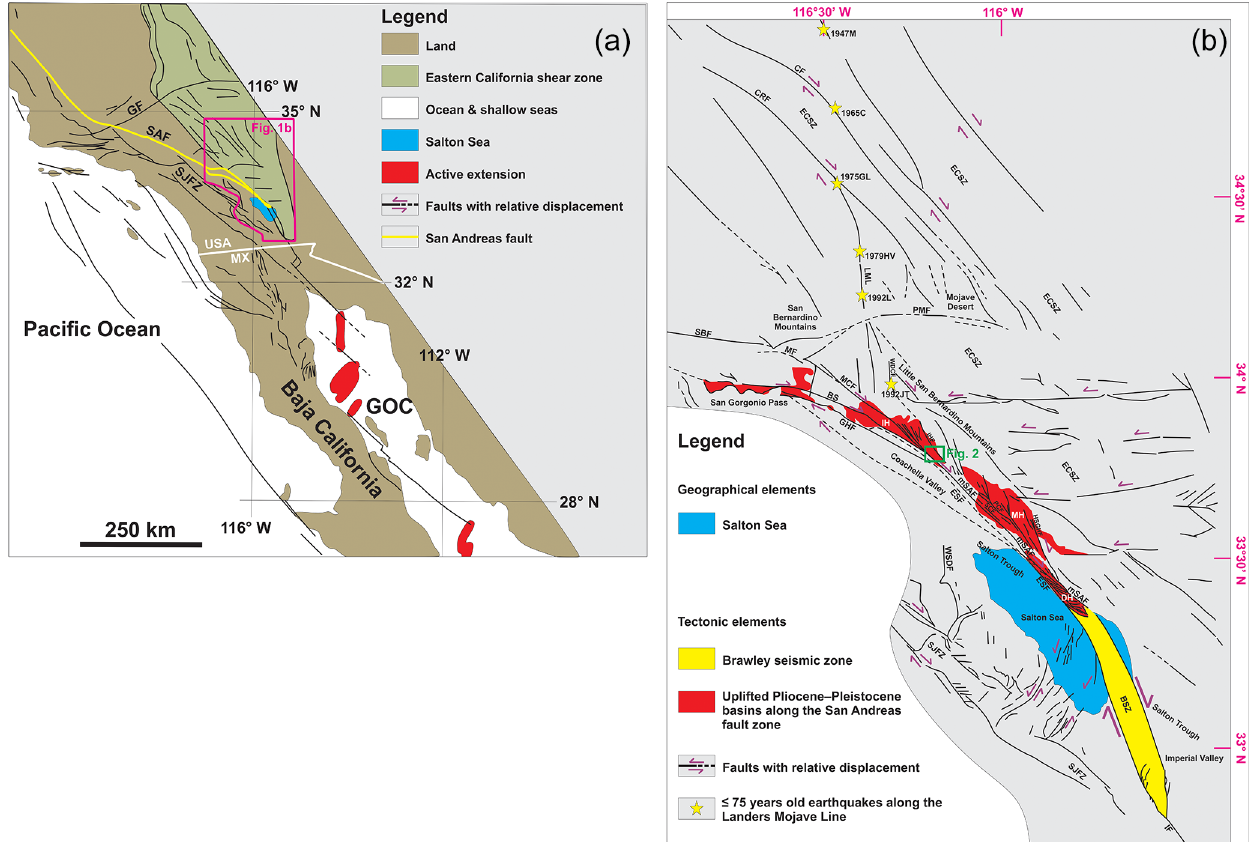
Figure 1. (a) Map of the main geological features of southern California, Baja California, and the Gulf of California. The location of (b) is shown as a fuchsia polygon. Modified after Janecke et al. (2018). (b) Simplified geological map of the Coachella Valley and Salton Trough, southern California, showing the three main transpressional uplift areas along the SAFZ: the Indio Hills (IH), Mecca Hills (MH), and Durmid Hills (DH). Note the link of the SAFZ with the Brawley seismic zone to the south. The study area is shown in a green rectangle. Recent earthquakes ( ≤ 75 years) along the Landers–Mojave Line (LML) are shown as yellow stars with associated year of occurrence. Faults are drawn after Rymer (2000), Guest et al. (2007), Janecke et al. (2018), and Bergh et al. (2019). Earthquakes after Nur et al. (1993a, b). Abbreviations: 1947M: 1947 Manix earthquake; 1965C: 1965 Calico earthquake; 1975GL: 1975 Galway Lake earthquake; 1979HV: 1979 Homestead Valley earthquake; 1992JT: 1992 Joshua Tree earthquake; 1992L: 1992 Landers earthquake; BS: Banning strand; BSZ: Brawley seismic zone; CF: Calico fault; CRF: Camp Rock fault; DH: Durmid Hills uplift; ECSZ: eastern California shear zone; ESF: East Shoreline fault; GF: Garlock fault; GHF: Garnet Hill fault; GOC: Gulf of California; HSGHF: Hidden Springs–Grotto Hills fault; IF: Imperial fault; IH: Indio Hills uplift; IHF: Indio Hills fault; LML: Landers–Mojave Line; MCF: Mission Creek fault; MF: Mill Creek fault; MH: Mecca Hills uplift; mSAF: main San Andreas fault; PCF: Painted Canyon fault; PMF: Pinto Mountain fault; SBF: San Bernardino fault; SCF: Skeleton Canyon fault; SJFZ: San Jacinto fault zone; WDCF: West Deception Canyon fault; WSDF: West Salton detachment